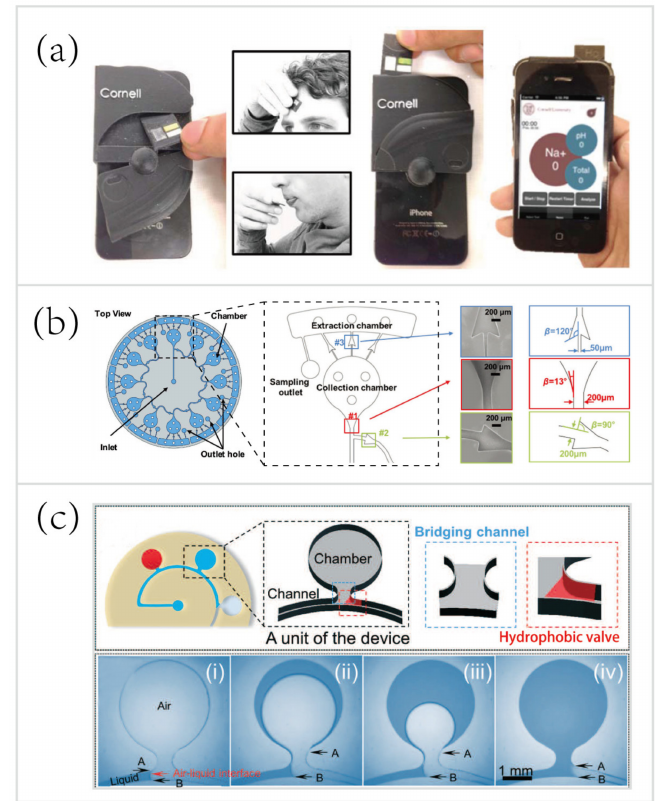
Figure 2. Representative examples of sweat sampling modalities. ( a ) A smartphone-based sweat biosensor, consistingofadisposableteststripforsweatsamplingviadirectcontact[126]. Copyright 2013, Royal Society of Chemistry. ( b ) A microfluidic biosensor with capillary bursting valves (CBVs) for sampling sweat in a sequential manner and with an interconnected set of chambers for the temporary storage of sweat samples for subsequent ex-situ analysis of sweat biomarkers [63]. Copyright 2017, Wiley. ( c ) A skin-interfaced microfluidic biosensor with sweat collection chambers and hydrophobic valves (HVs) for chrono-sampling of sweat; ( i )—( iv ) A series of images during the fluid sampling for demonstrating the working principle of HVs [128]. Copyright 2020, Royal Society of